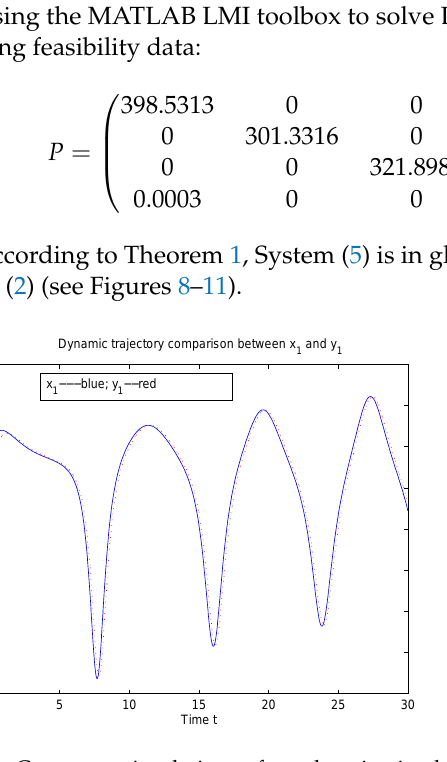
Figure 8. Computer simulations of synchronization between x 1 and y 1 for α = 1.